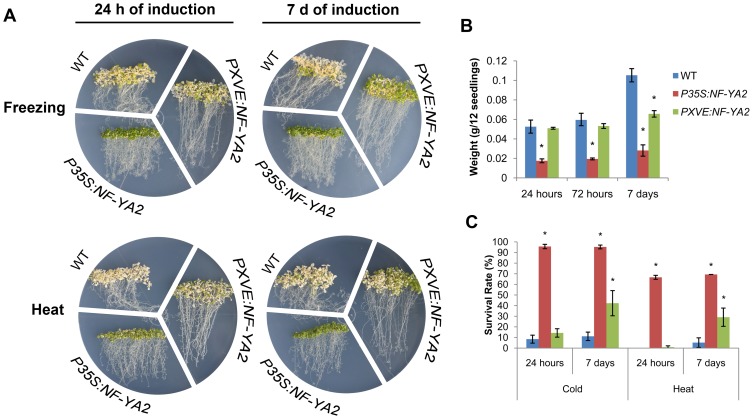
Long-term expression of NF-YA2 confers tolerance to freezing and heat.(A) Images of eight-day-old WT, P35S:NF-YA2 and PXVE:NF-YA2 seedlings grown on 0.1× MS that were transferred to 0.1× MS+ β-estradiol (7 µM) for 24 h or 7 days prior to stress. Photographs were taken after four and seven days of recovery time for freezing (−7°C/4 h, lids off) and heat (45°C/2 h, lids on) treatments, respectively. (B) Weight of 12 seedlings of each line was determined at the indicated induction times. Data represent means and SD of three replicates statistically treated using a student t-test (*P<0.05). (C) Average survival rate of each plant line subsequent to the stress assay (n>50). Data represent means and SD of three replicates statistically treated using a student t-test (*P<0.05).